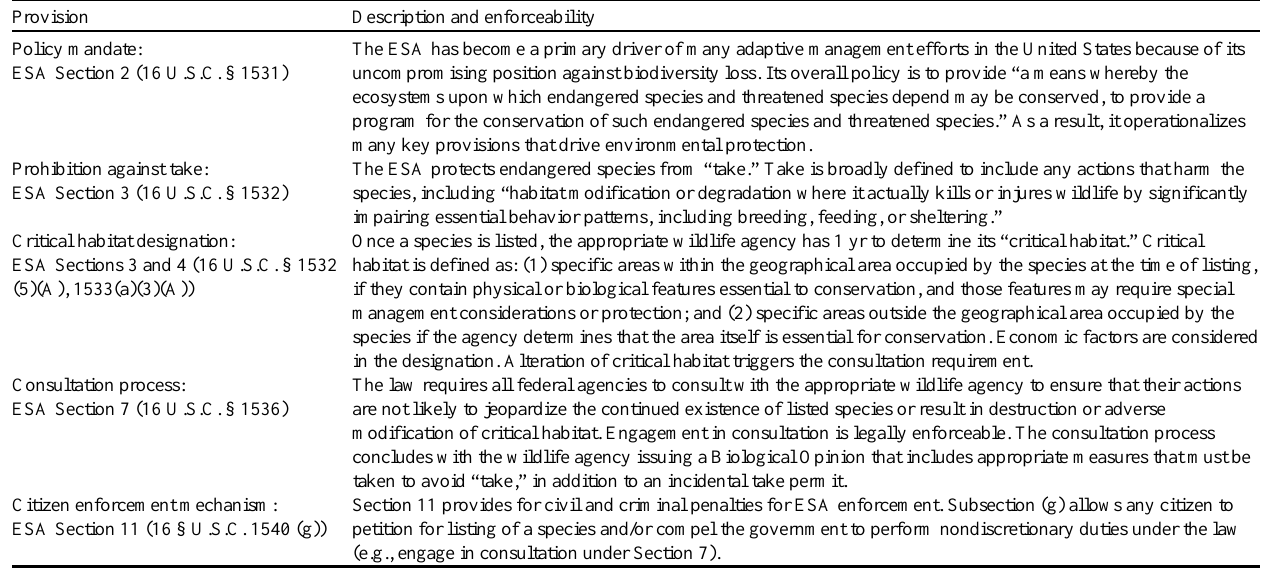
Table 2. Summary of the Endangered Species Act (ESA) and its key provisions (Benson